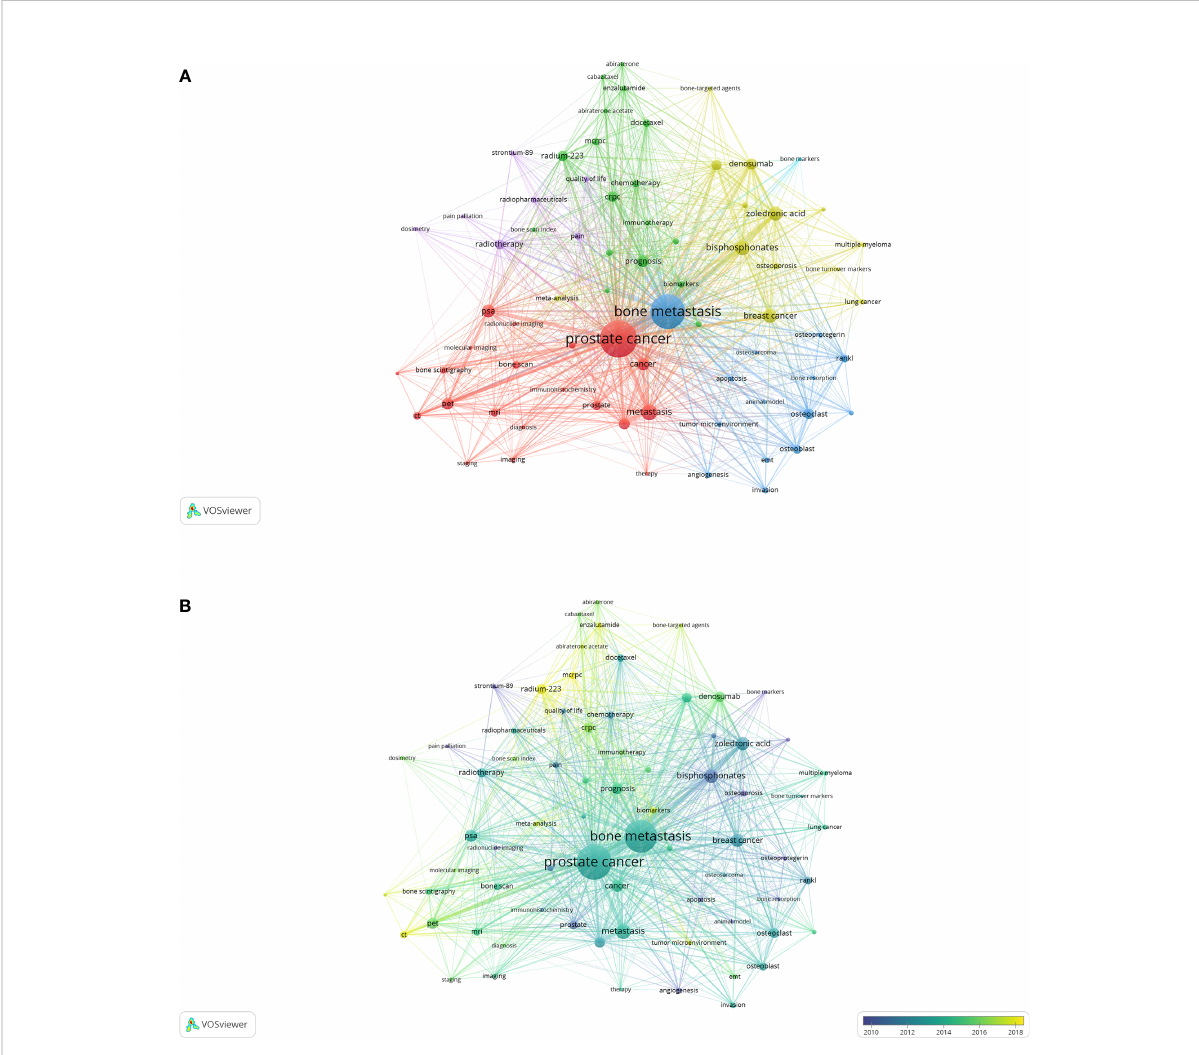
FIGURE 9 Networks generated by VOSviewer. (A) Visualization map of the author keywords with more than 20 occurrences. (B) Overlay visualization map of the author keywords with more than 20